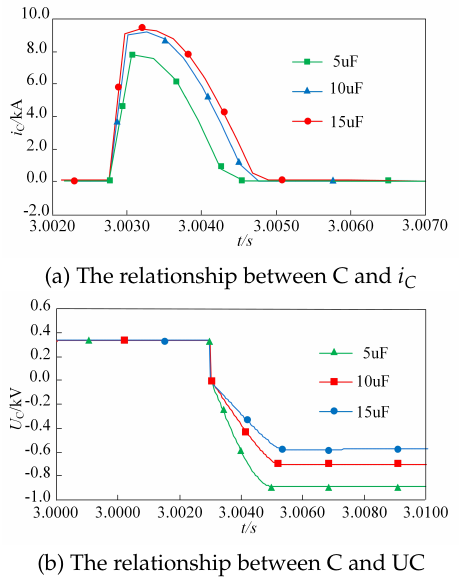
Fig. 5. Relationship between C, i dc and UC